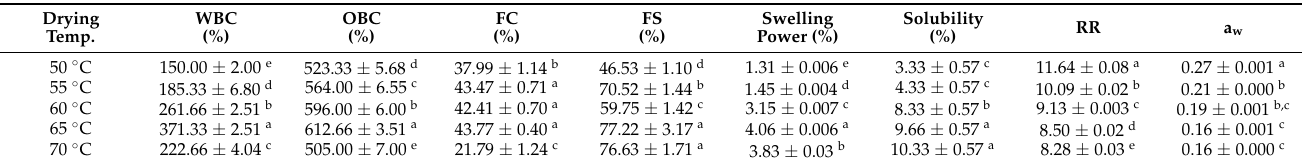
Table 4. Effect of drying temperature on functional properties, rehydration ratio, and water activity of